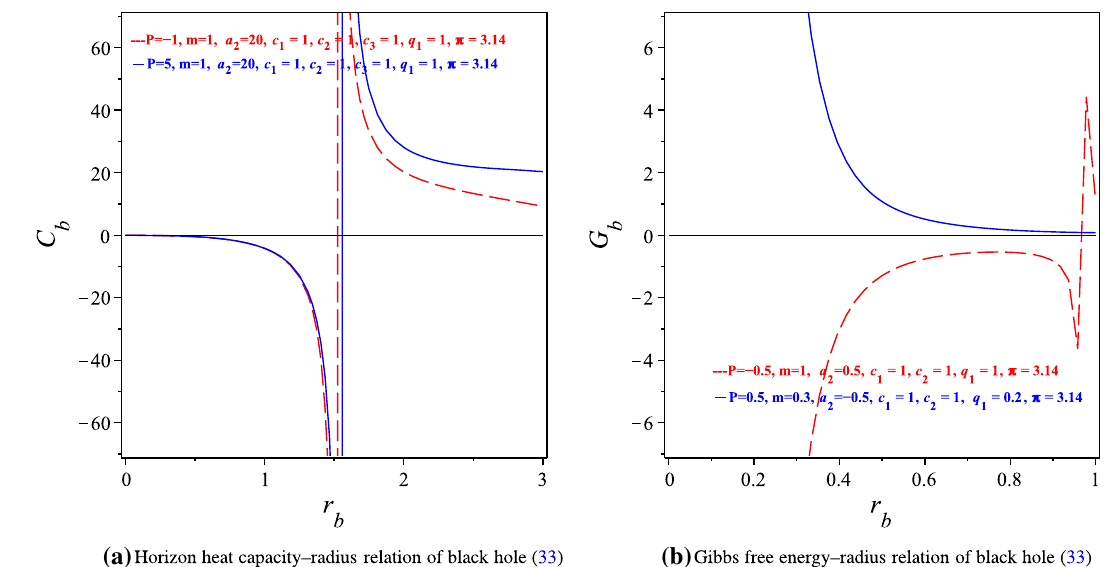
Fig. 3 Schematic plot of the heat capacity shows the locally unstable event horizon which is characterized by the negative C h < 0. Also, the plot shows a second-order phase transition as C h diverges; b shows free energy of black hole